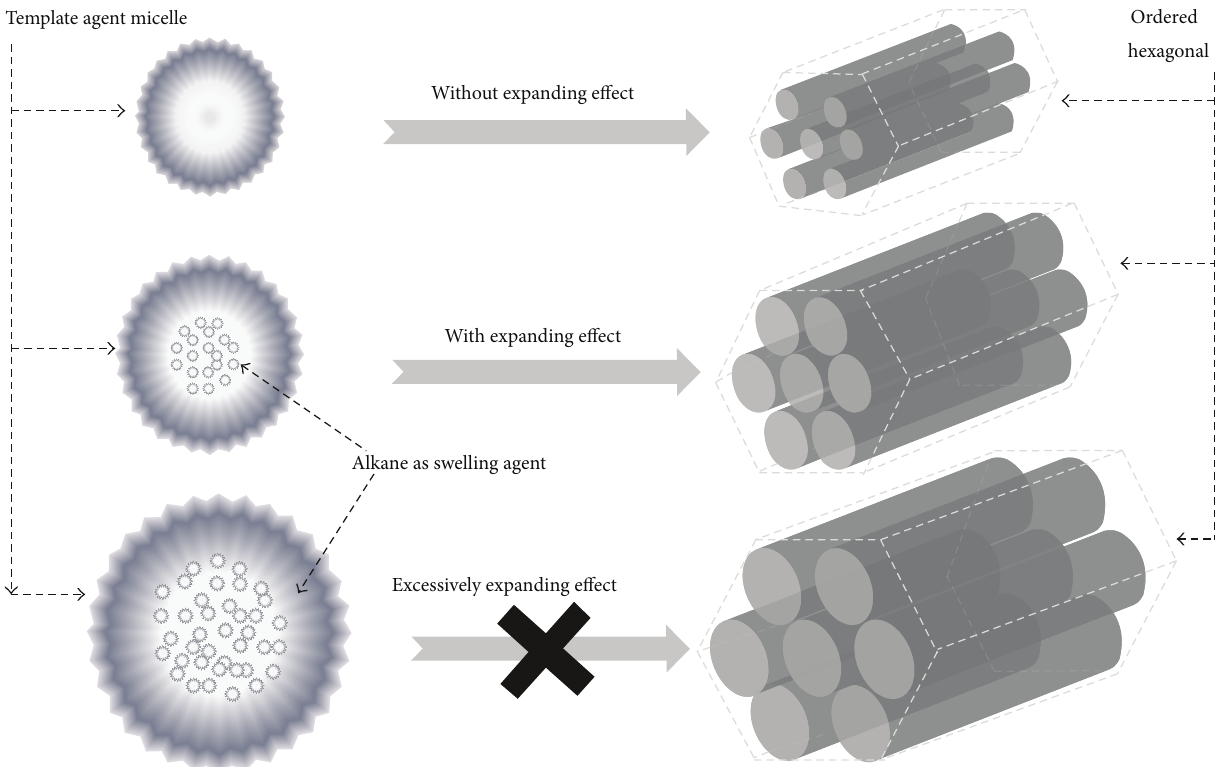
Figure 1: Tuning the pore size of ordered MSM with alkanes as swelling